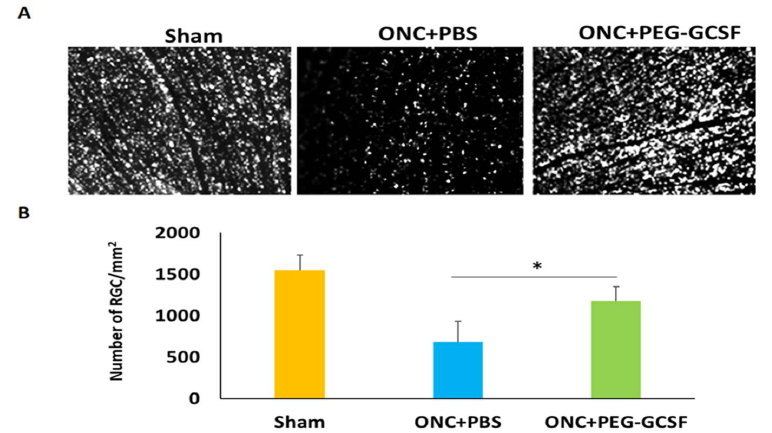
7 of 16 . Figure 4. Assessment of visual function by flash visual-evoked potential (fVEP) examination 14 days after optic nerve crush (ONC). ( A ) Representative records of fVEP wavelets in the sham group, the phosphate-buffered saline (PBS)-treated and the pegylated granulocyte colony-stimulating factor (PEG-G-CSF)-treated ONC groups. ( B ) The bar chart showed the measure of the peak to peak amplitudes of P1–N2. There was a significant improvement in the fVEP in the PEG-G-CSF-treated group as compared with that in the PBS-treated group after ONC (* p < 0.05, n = 6). P1, the first positive peak; N2, the second negative peak. Data are expressed as mean ± standard deviation (SD). 3.4. Treatment with PEG-G-CSF Improves RGCs Survival and Declines Their Apoptosis The PEG-G-CSF-treated group preserved a higher density of RGCs in the central retinas than the PBS-treated group (Figure 5A). Two weeks after ONC was conducted, the RGC densities in the central retinas in the sham group, the PBS- and the PEG-G-CSF-